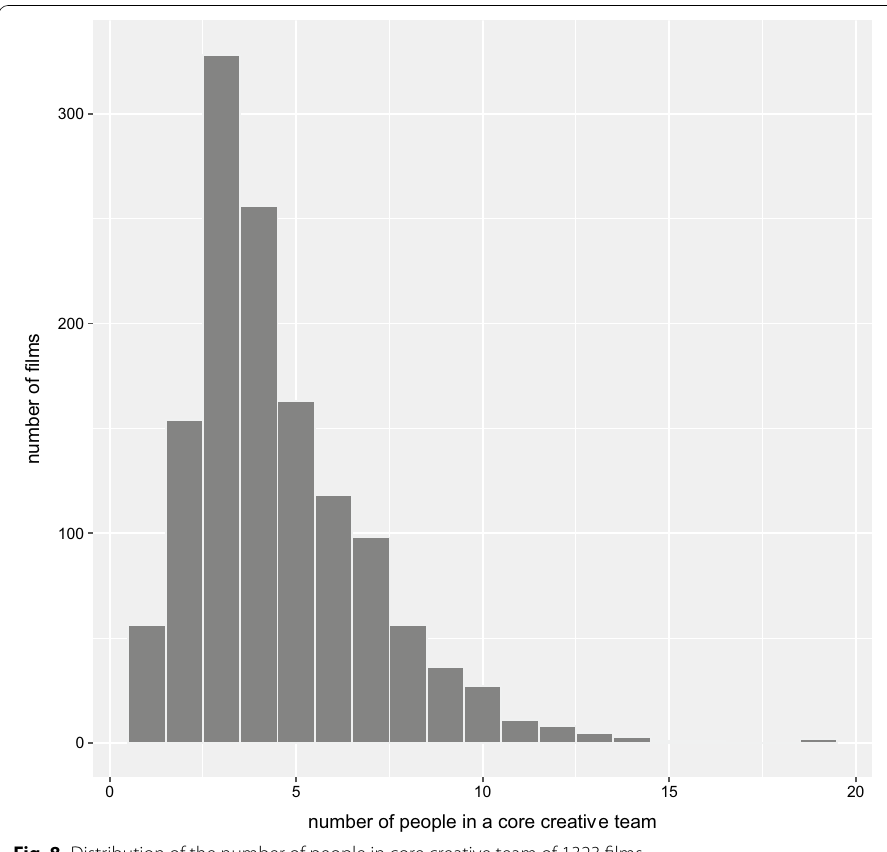
Fig. 8 Distribution of the number of people in core creative team of 1323